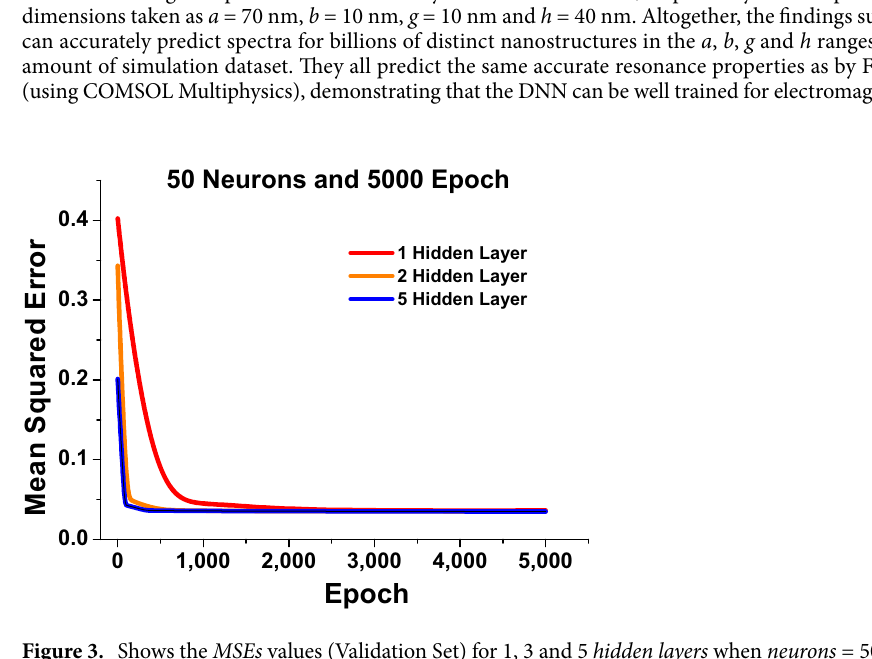
Figure 3. Shows the MSEs values (Validation Set) for 1, 3 and 5 hidden layers when neurons = 50 and epoch =